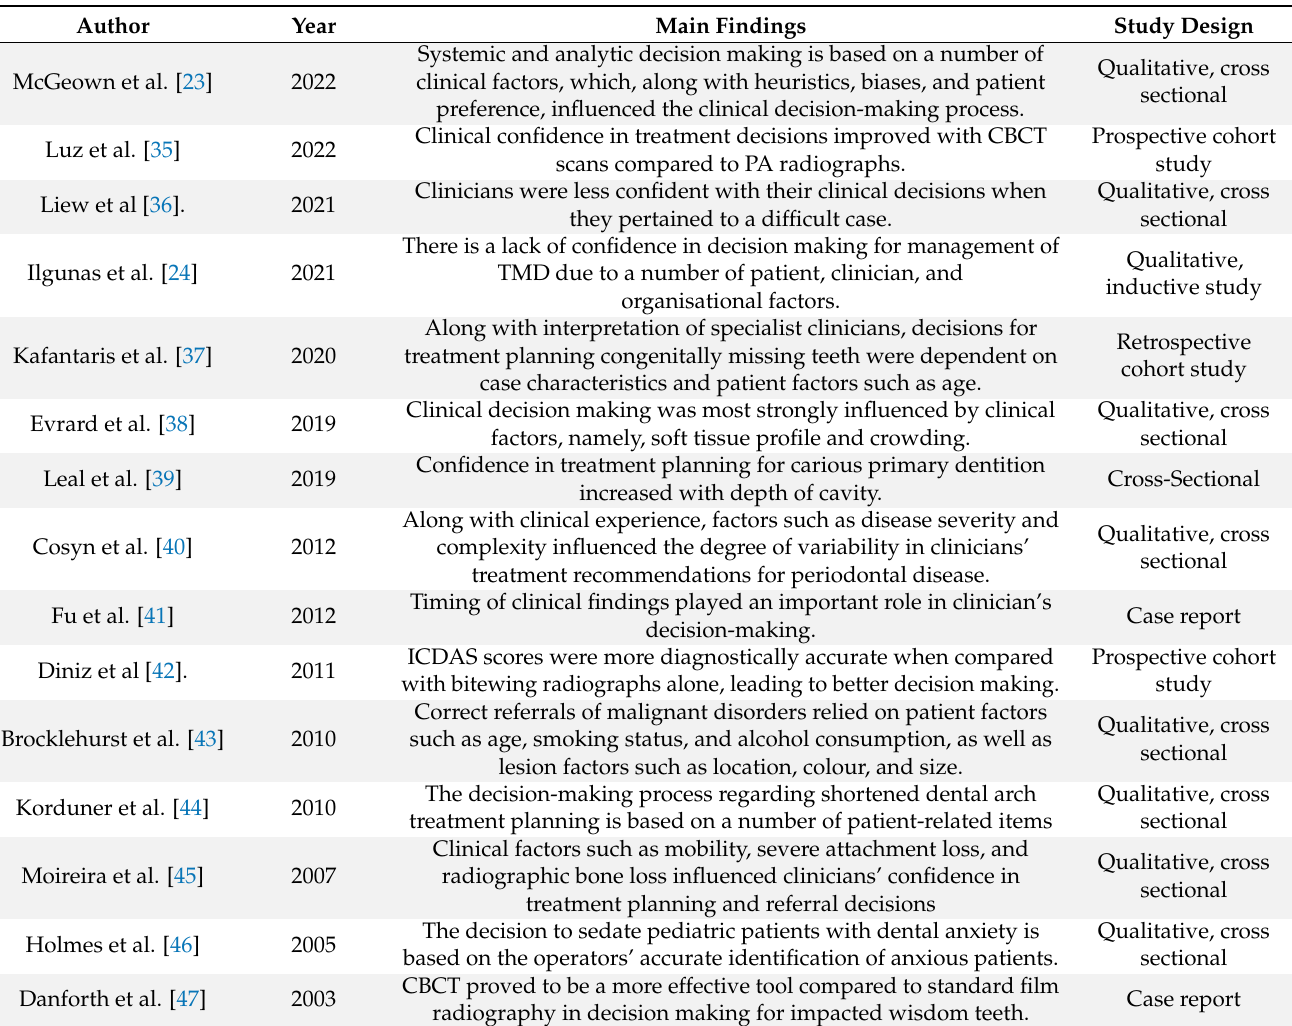
Table 2. Extracted articles that investigated clinical factors affecting clinical decision making un- der